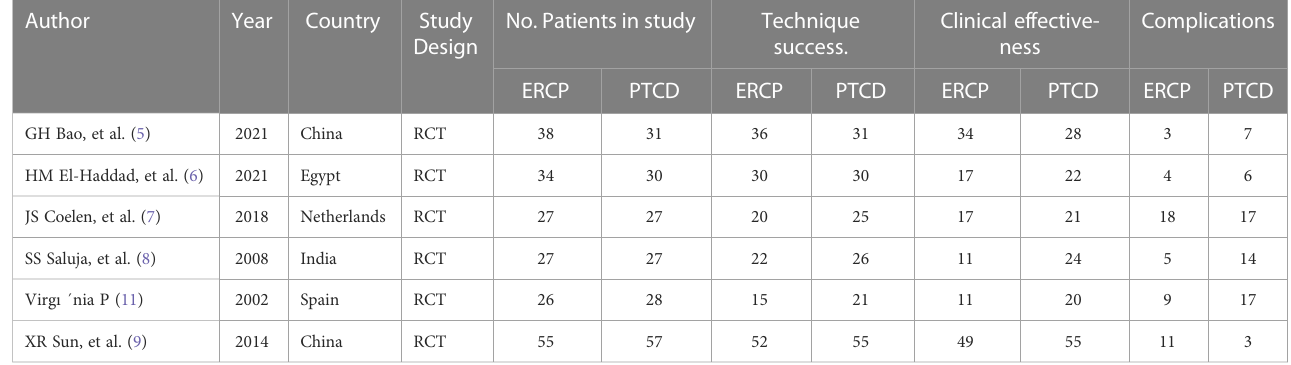
TABLE 1 Main characteristics of the included literature.